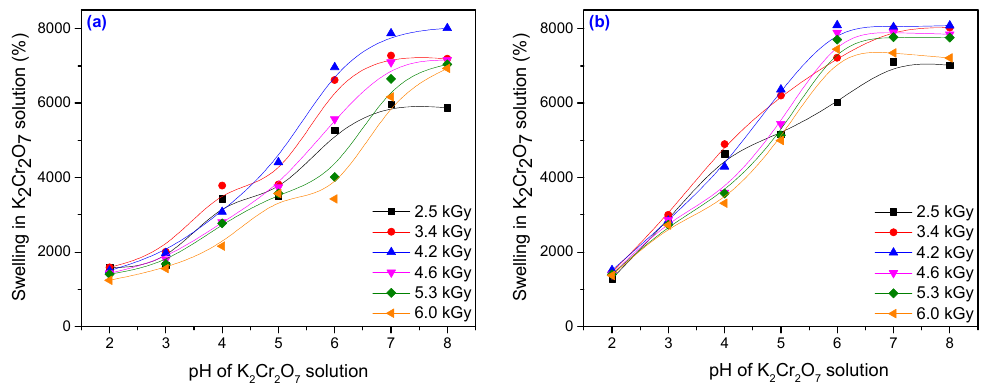
Figure 13. Swelling of the hydrogels in K 2 Cr 2 O 7 solution as a function of pH, PP and TMPT amount: ( a ) 3.70 × 10 − 3 mol/L PP and 2.95 × 10 − 3 mol/L TMPT; ( b ) 7.40 × 10 − 3 mol/L PP and 5.90 × 10 − 3 mol/L TMPT.